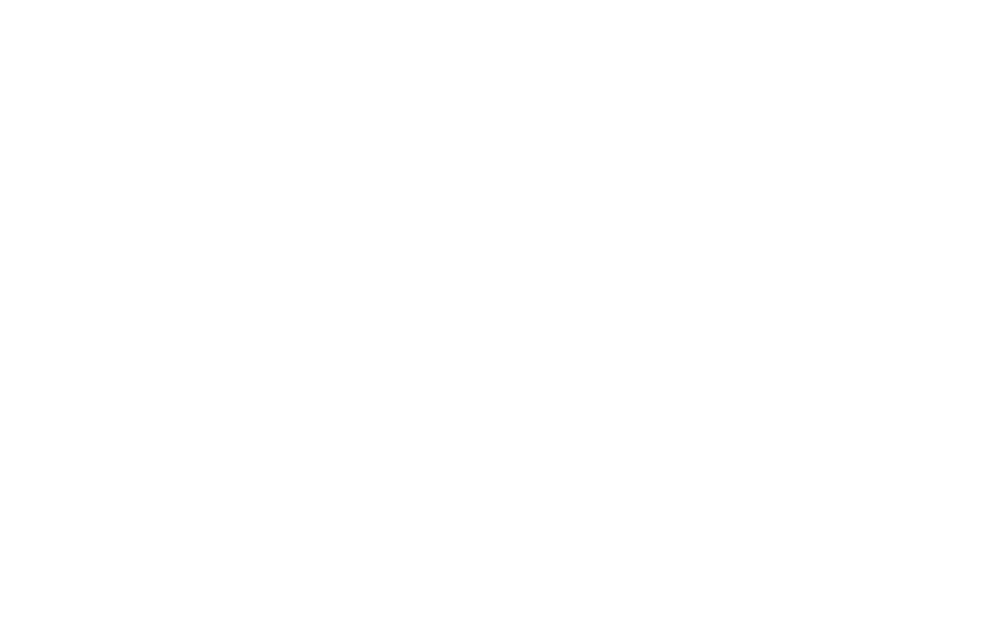
FIGURE A1 | Subpopulation of a neuronal network before and after laser induced lesions. The first panel, starting from the left upper corner, shows a subpopulation of a neuronal network loaded with Fuo4-AM. White arrows, depicted with L1 and L2, indicate the positions of the lesions inflicted to the network. The red arrows indicate the position of the UV laser focus spot. The average power delivered at the sample, during lesion one, is 4 μ W, and during Lesion